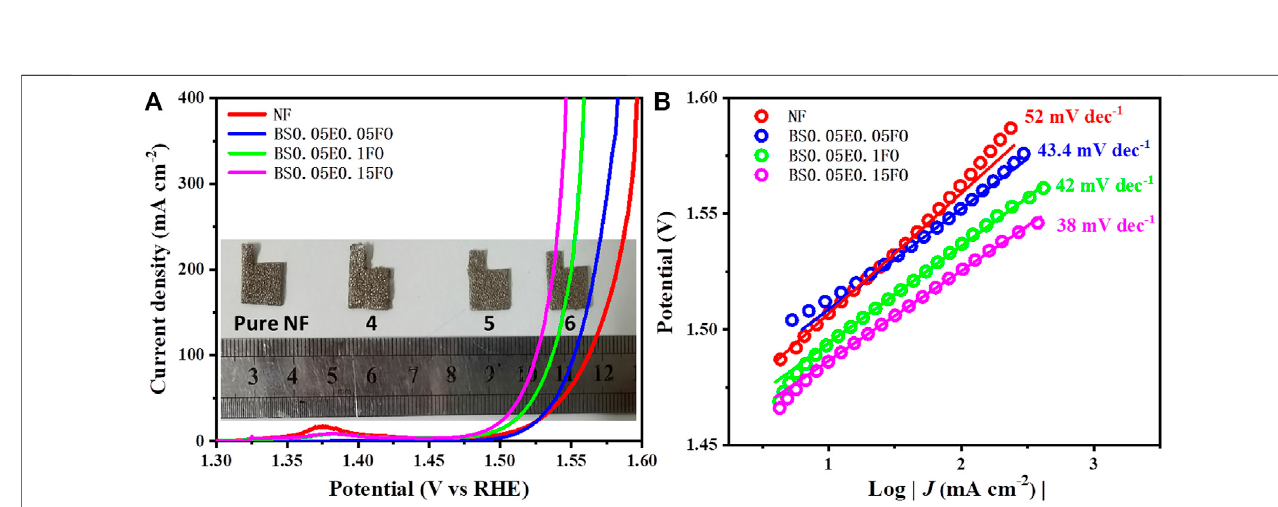
FIGURE6|(A) Polarizationcurvesand (B) correspondingTafelplotsofNFandBi 0.95 Sm 0.05 Fe 1 − x Eu x O 3 ( x =0.05,0.10,0.15)samplesdepositedonNFs,withtheir digital photos inserted in (A) .